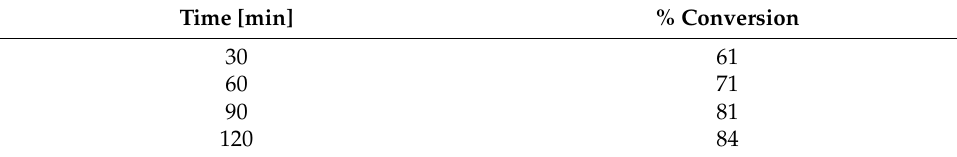
Table 6. Results for kinetic tests with CNS-Zn a .